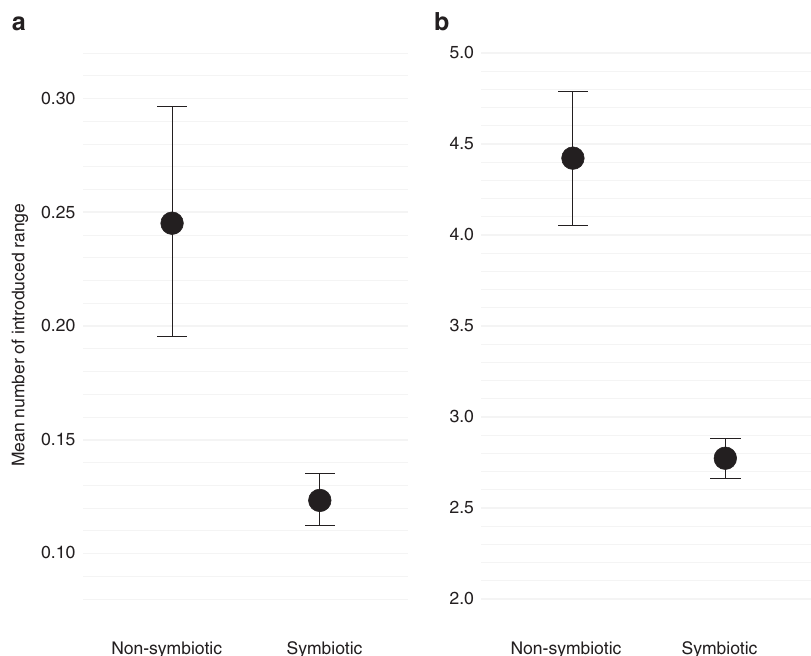
Figure 2 | Non-native ranges between symbiotic and non-symbiotic legumes species. ( a ) Mean number of introduced ranges across all legume species studied (including those with no introduced ranges) [( n total ¼ 180,030 ¼ ( n species ¼ 3,530) (cid:3) (n regions ¼ 51)]. ( b ) Mean number of introduced ranges for legume species recorded from at least one non-native region [( n total ¼ 41,412 ¼ ( n species ¼ 812) (cid:3) ( n regions ¼ 51)]. A species’ introduced range is defined by a list of geographic regions of non-native occurrence. Points and error bars represent the mean and 95% confidence intervals from parametric bootstraps, controlling for all covariates (absolute native latitude, total native area, life form, life history, area of non-native region and number of human